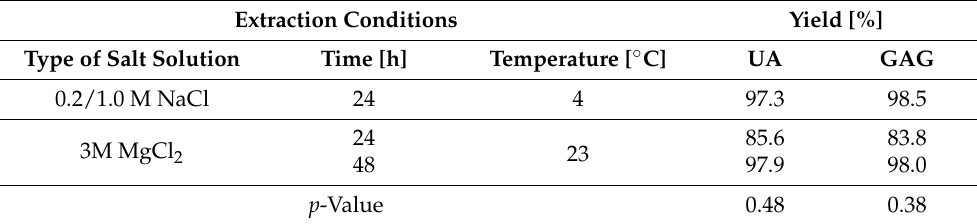
Table 2. The extraction yield of uronic acid (UA) and glycosaminoglycans (GAG). Extraction